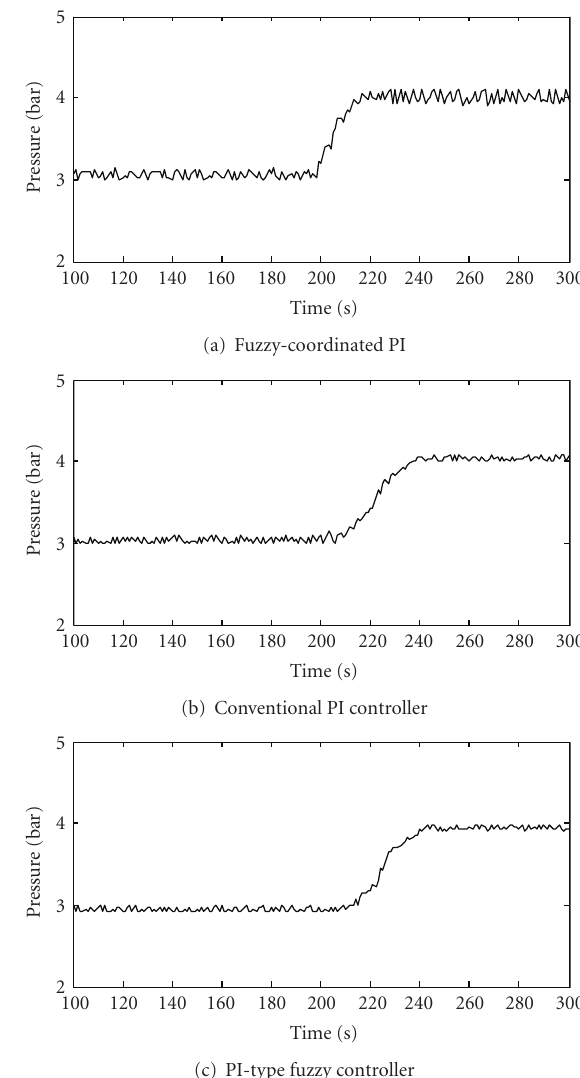
Figure 10: Experimental results, output responses of di ff erent controllers for the set-pressure level of 4bar.